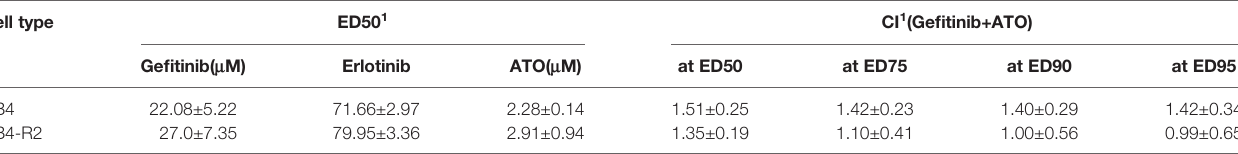
TABLE 1 | The 50% effective dose (ED 50 ) values of ge fi tinib, erlotinib, and arsenic trioxide (ATO) in NB4 and NB4-R2 cells, and combination index (CI) values of ge fi tinib plus ATO at different effective levels. Cell